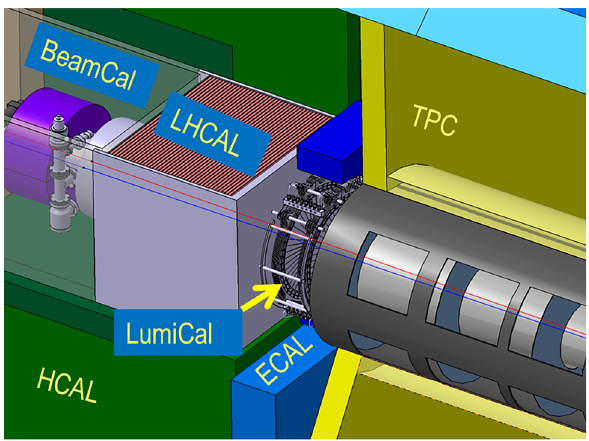
Fig. 1 The very forward region of the ILD detector. LumiCal, Beam- Cal and LHCAL are carried by the support tube for the final focusing quadrupole and the beam-pipe. TPC, ECAL and HCAL are the Time Projection Chamber and the Electromagnetic and Hadron